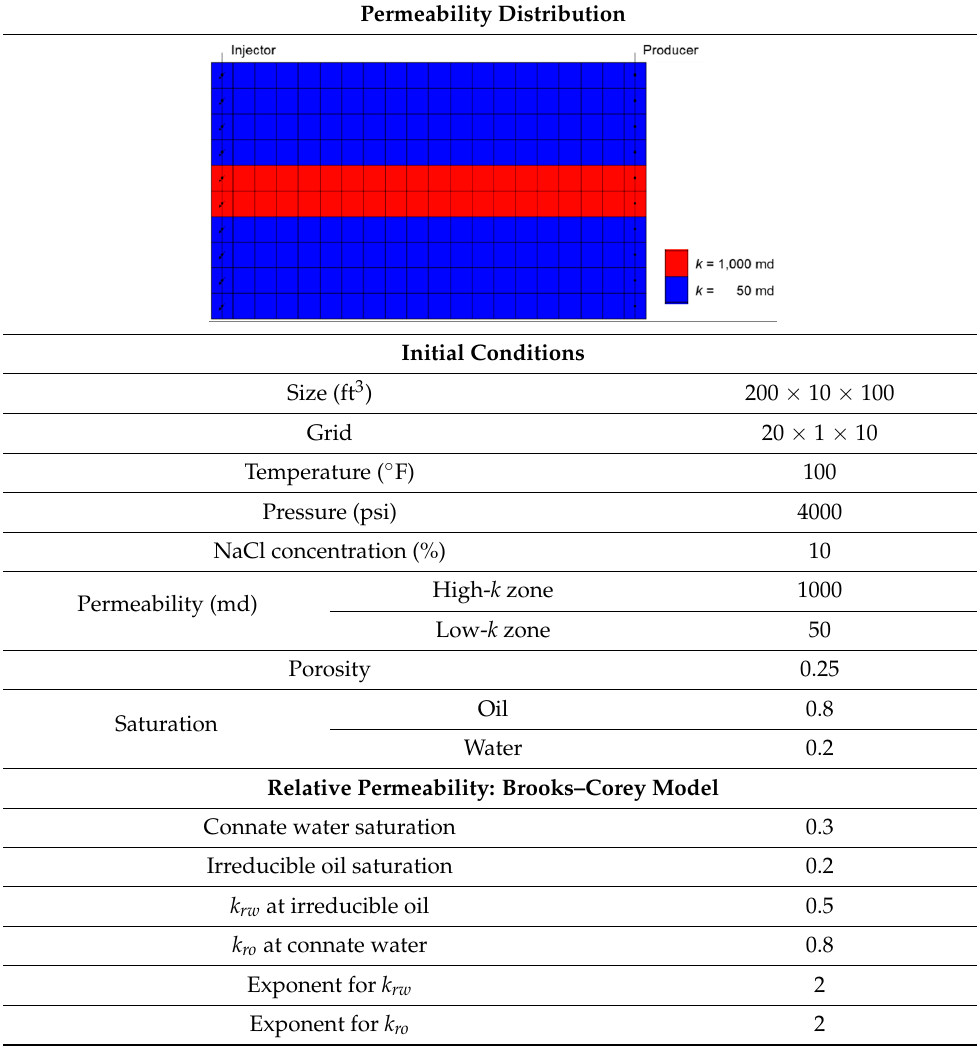
Table A3. Description of the initial conditions of the target reservoir [54].